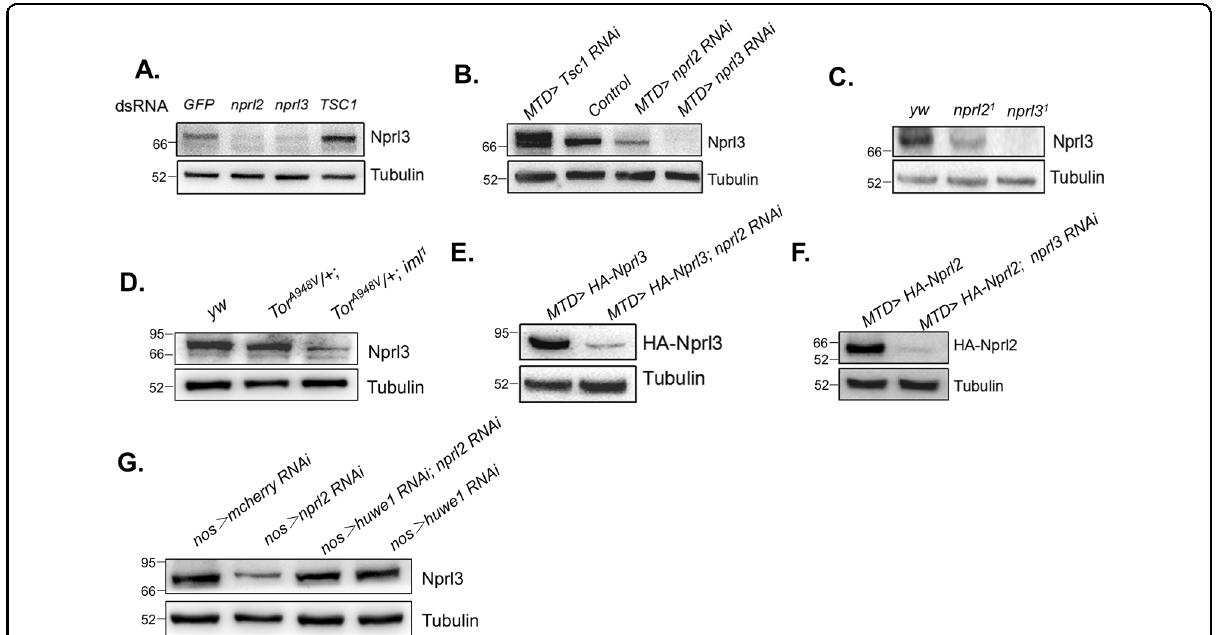
Fig. 1 Nprl3 and Nprl2 expression levels are interdependent. A Western blot analysis of Nprl3 protein in the indicated dsRNA treated S2 cells. B Western blot analysis of Nprl3 protein in the ovaries of MTD > mCherry RNAi (control), MTD > nprl2 RNAi , MTD > nprl3 RNAi and MTD > Tsc1 RNAi fl ies. C Western blot analysis of Nprl3 protein in the ovaries of yw (control), nprl2 1 and nprl3 1 . D Western blot analysis of Nprl3 protein in the ovaries of yw , Tor A948V / + and Tor A948V / + ; iml1 1 . E Western blot analysis of HA-Nprl3 protein in the ovaries of MTD > HA-Nprl3 and MTD > HA-Nprl3, nprl2 RNAi fl ies. F Western blot analysis of the HA-Nprl2 protein in the ovaries of MTD > HA-Nprl2 and MTD > HA-Nprl2, nprl3 RNAi fl ies. G Western blot analysis of Nprl3 protein in the ovaries of nos > mCherry RNAi (control) , nos > nprl2 RNAi , nos > nprl2 RNAi, huwe1 RNAi and nos > huwe1 RNAi fl ies. α -Tubulin was used as a loading control. Similar western blot results were observed in more than three independent experiments for each